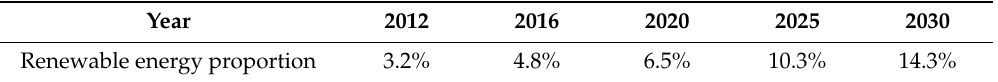
Table 1. Target renewable energy proportion based on the primary energy in South Korea.